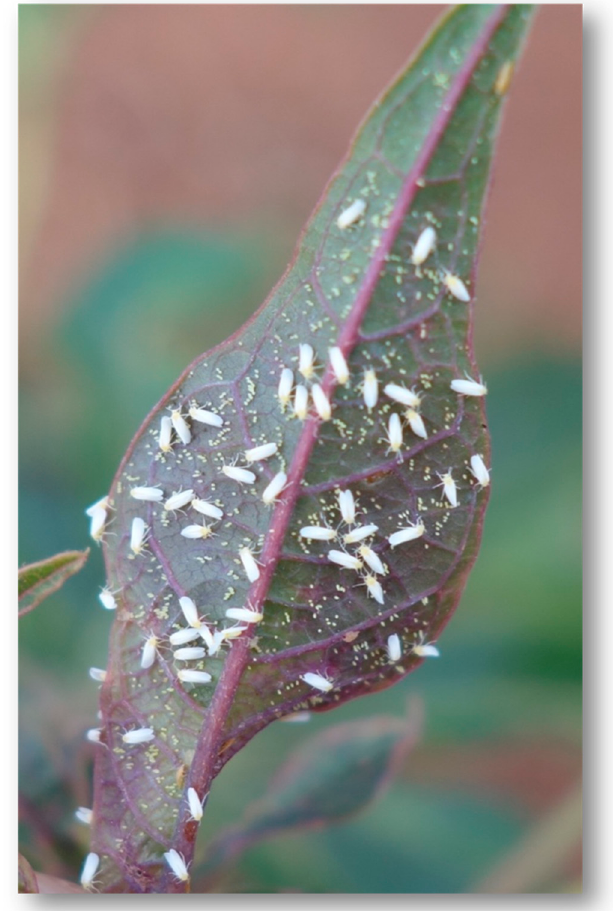
Figure 1. Bemisia tabaci SSA1 species on cassava (Photo: Laura M. Boykin).